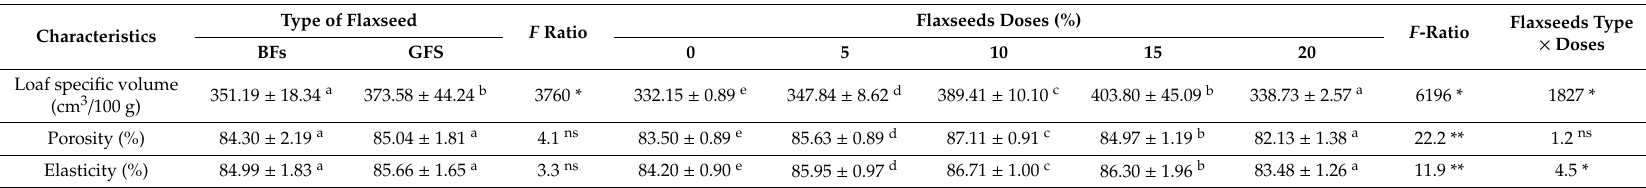
Table 6. Analysis of variance of the influence of flaxseeds from the brown variety (BFs) and golden variety (GFs) addition on the physical characteristics of bread obtained from a medium quality flour for